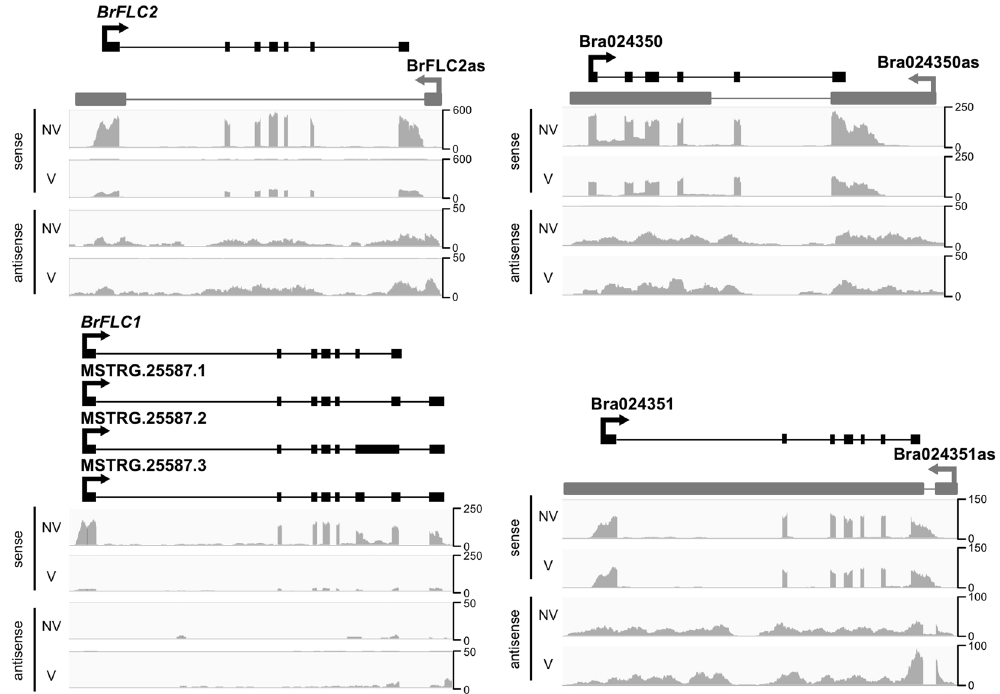
Figure 6. Strand-specific read coverage plots for BrFLC2 , BrFLC1 , Bra024350, and Bra024351. Above each coverage plot, the mRNA transcripts are shown in black and the antisense transcripts (NATs) are shown in gray, with exons represented as thick bars and an arrow showing the 5 ′ to 3 ′ sense, and thin lines illustrating the introns. For BrFLC1 , three splice isoforms are shown relative to the reference genome annotation, illustrating a conservation of mRNA structure for exons 1 through 5, with differential splicing occurring at exons 6 and